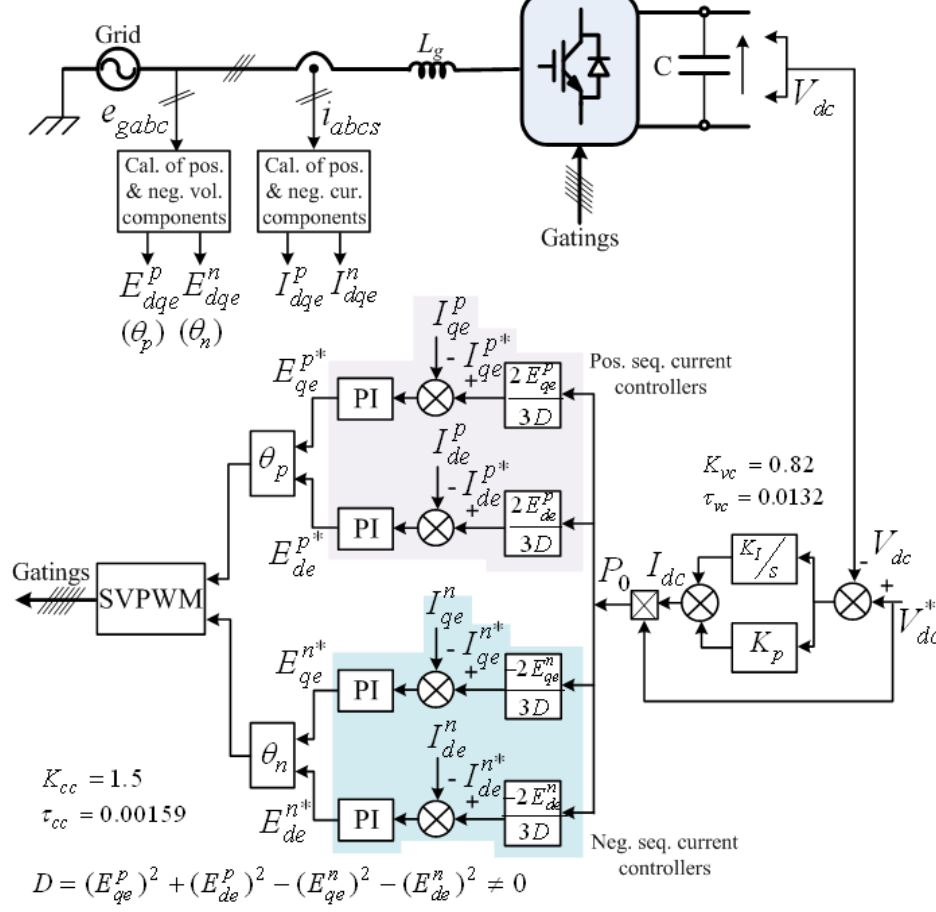
Figure 2. The control scheme of GSC